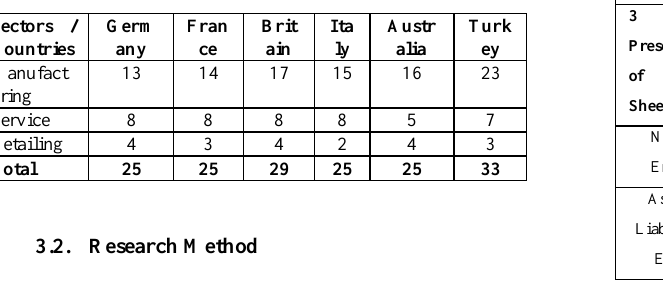
Table 1: Number of Entities Selected from Each Country Sectors / Countries